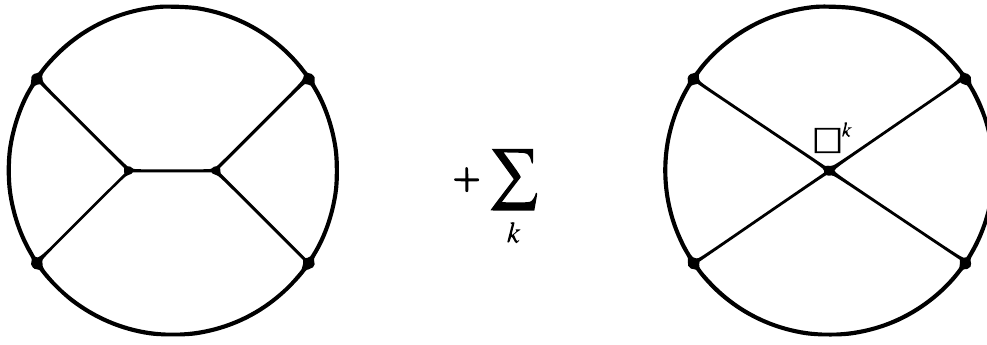
Figure 4 . The tree-level Witten diagrams that are relevant in the Regge limit for G N = 0 . Of course, the exchange diagram should be summed over all